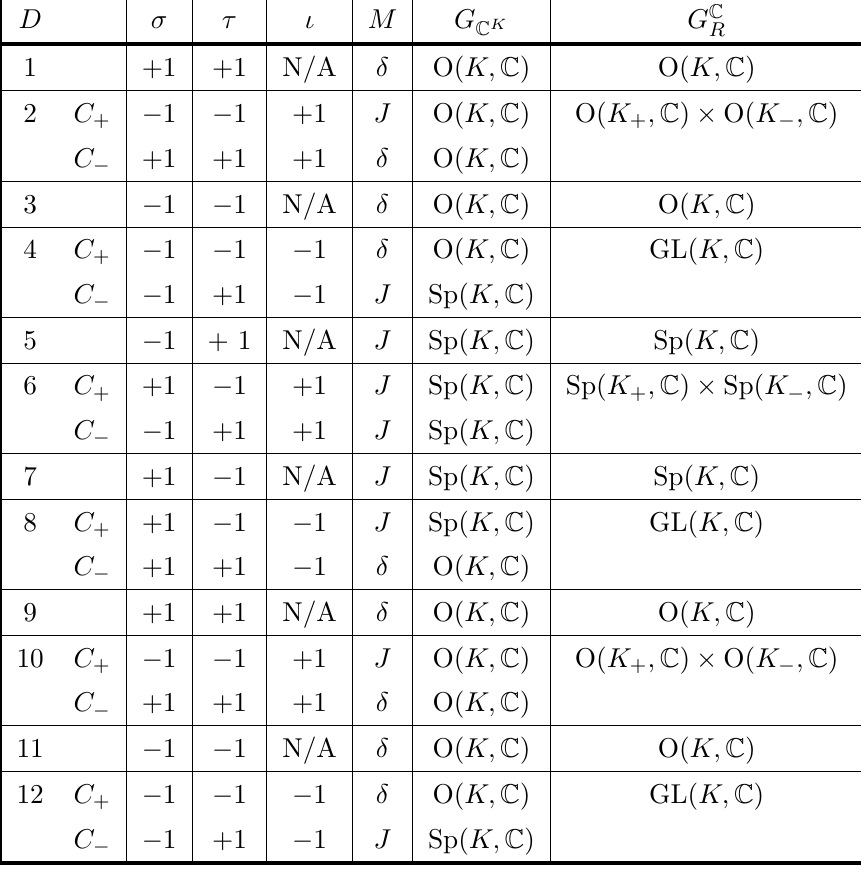
is the isometry group of M C K